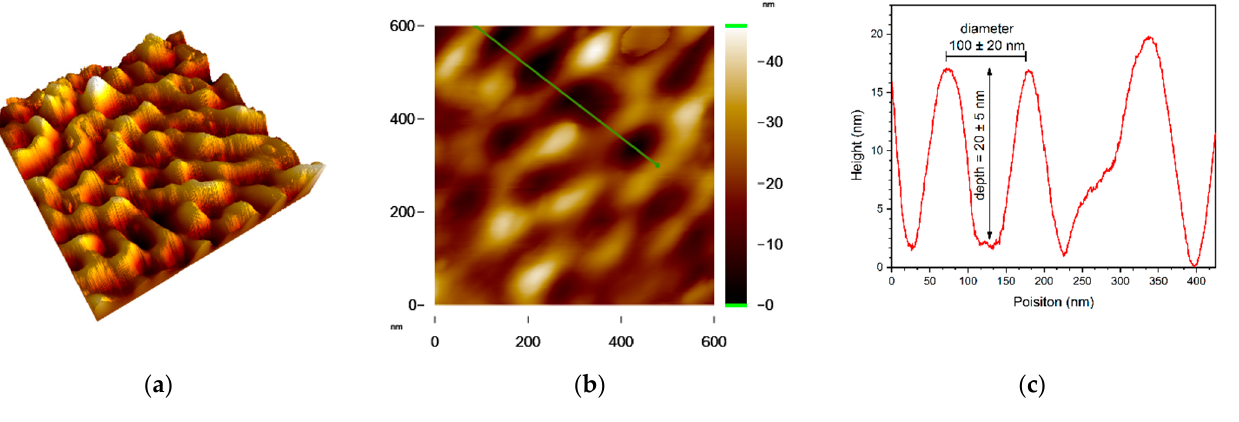
Figure 5. AFM images of the nanopatterned titanium surface ( cTi ): ( a ) 3D image of 1 × 1 μ m area, ( b ) 2D image of 600 × 600 nm area, and ( c ) line profile taken from the region marked with red line on Figure 5b.